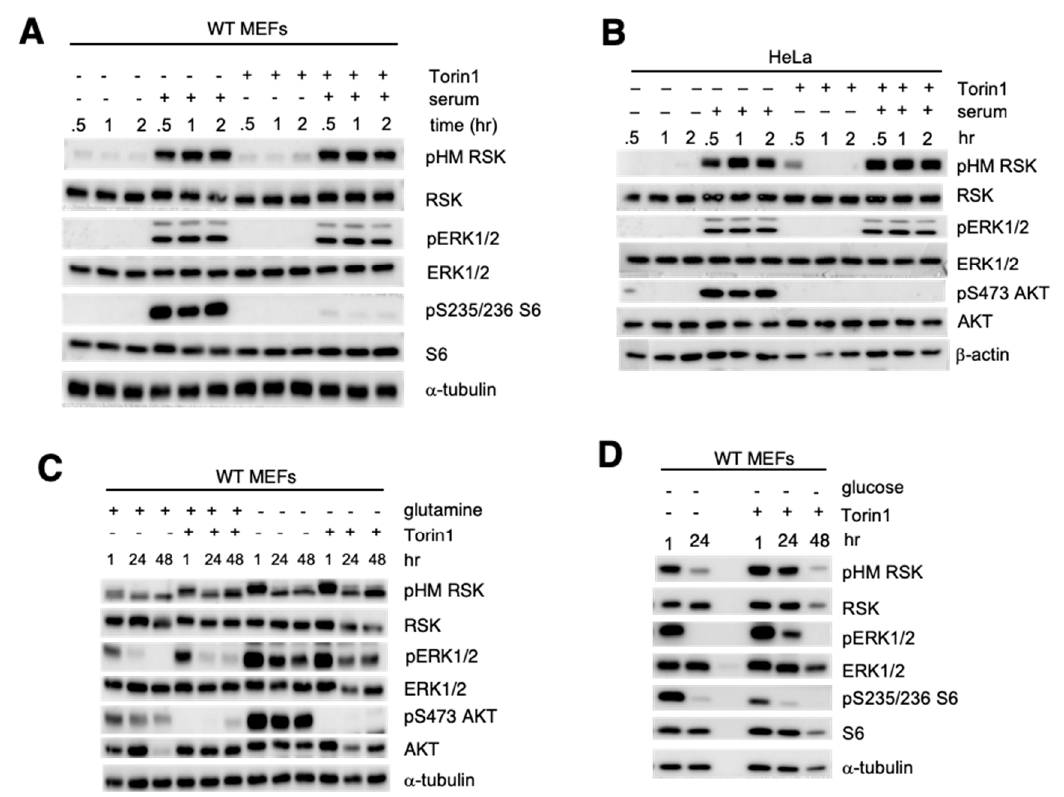
Figure 5. The catalytic activity of mTOR is not required for RSK HM site phosphorylation. ( A , B ) Growing WT MEFs ( A ) or HeLa cells ( B ) were supplemented with either 1 μ M Torin1, 1× FBS (serum) or both and incubated for the indicated times. ( C , D ) Growing WT MEFs were resuspended in media with dFBS, lacking ( − ) or containing) glutamine ( C ) or glucose ( D ). Torin1 (1 μ M) or vehicle ( − ) was added during resuspension and incubated at the indicated times.